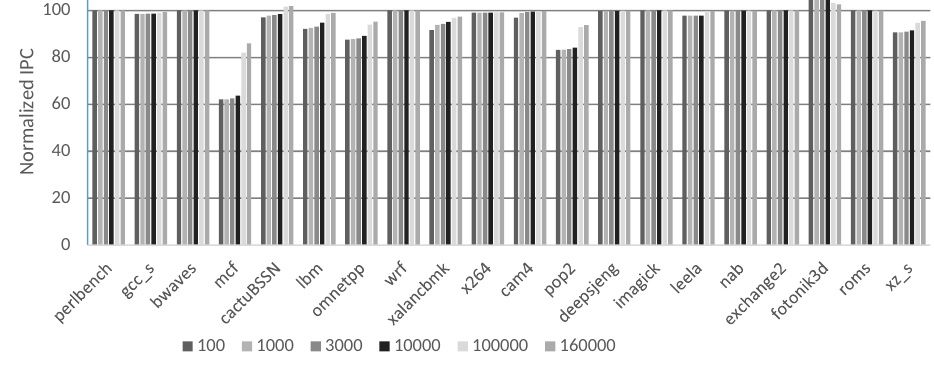
Figure 6: Instructions per Cycle (IPC), normalized to a cache system without randomization for different rekeying